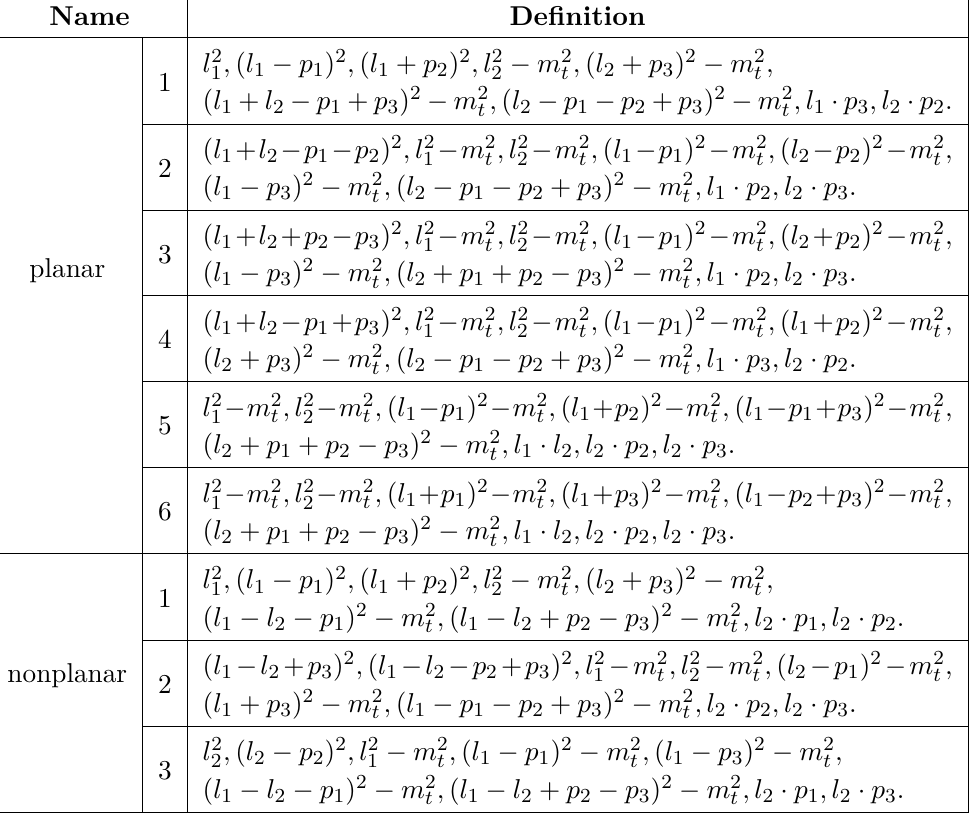
Table 4. Definitions of the integral families. l 1 and l 2 are loop momenta while p 1 , p 2 , and p 3 are external momenta defined in eq.